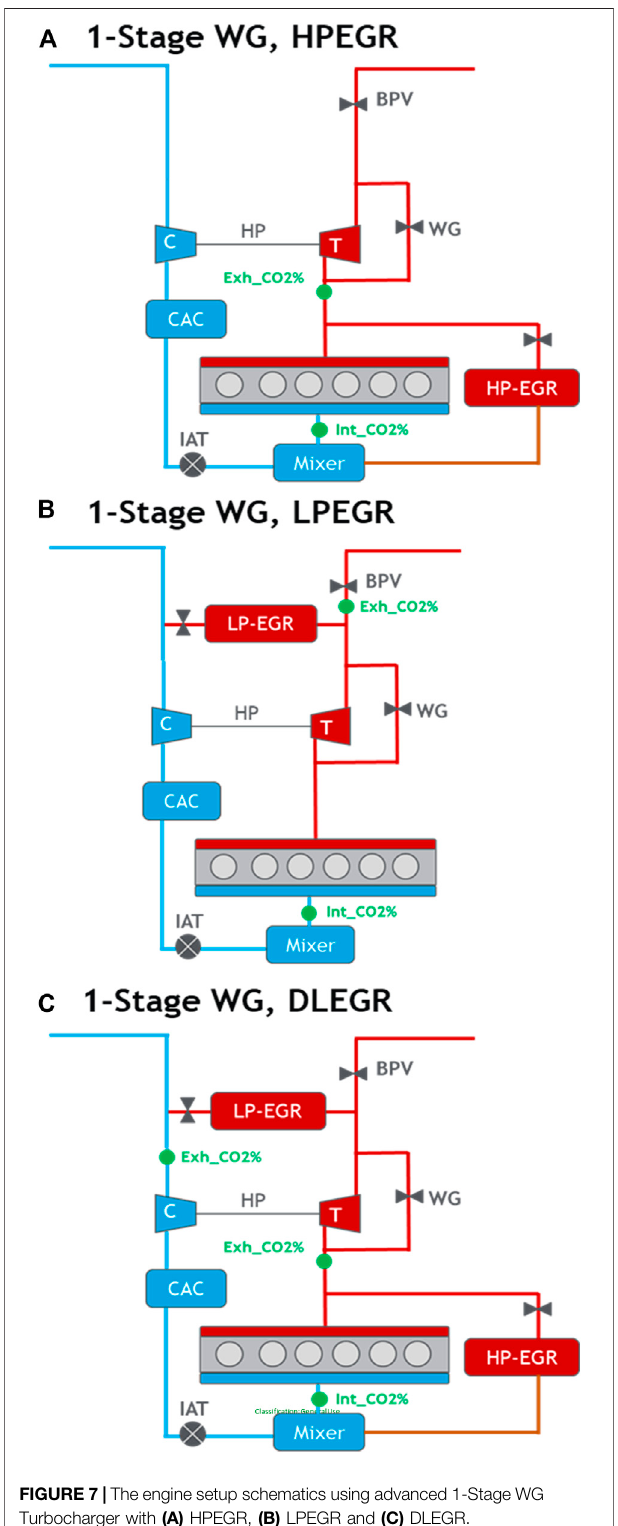
FIGURE 7 | The engine setup schematics using advanced 1-Stage WG Turbocharger with (A) HPEGR, (B) LPEGR and (C) DLEGR.